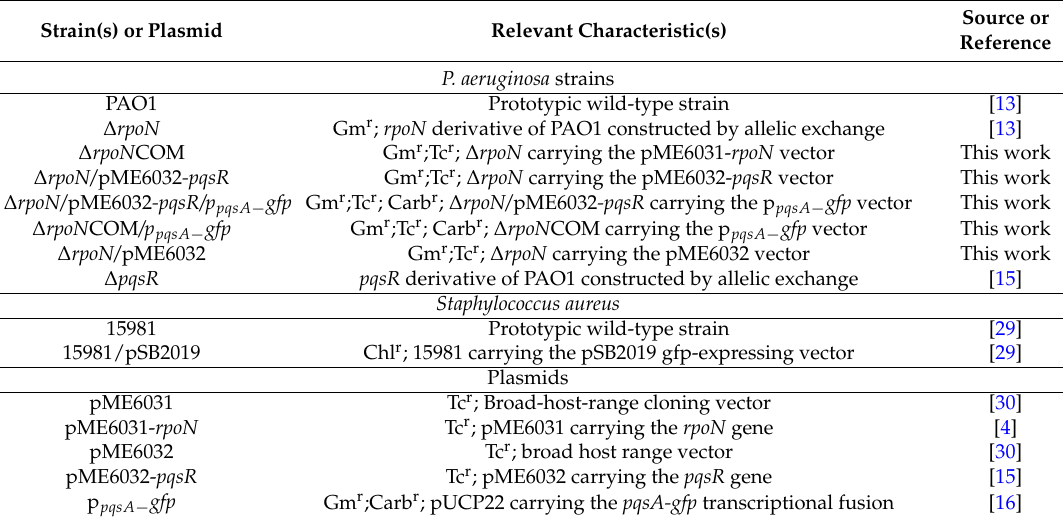
Table 1. Bacterial strains, plasmids and primers used in this